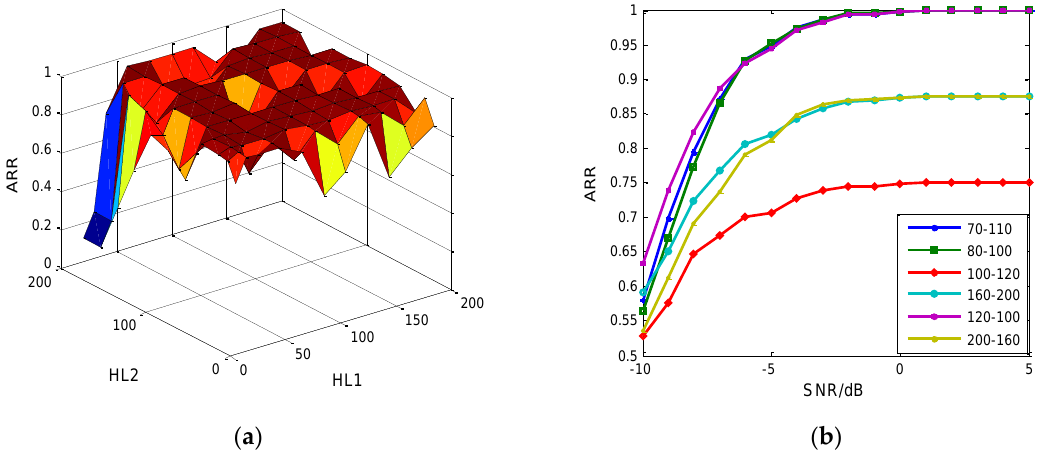
Figure 11. The parameter tuning of 2 hidden layer RDBN. ( a ) Effects on the recognition rate at −5 dB of nodes in hidden layers; ( b ) Examples of parameter tuning selected from the simulations.